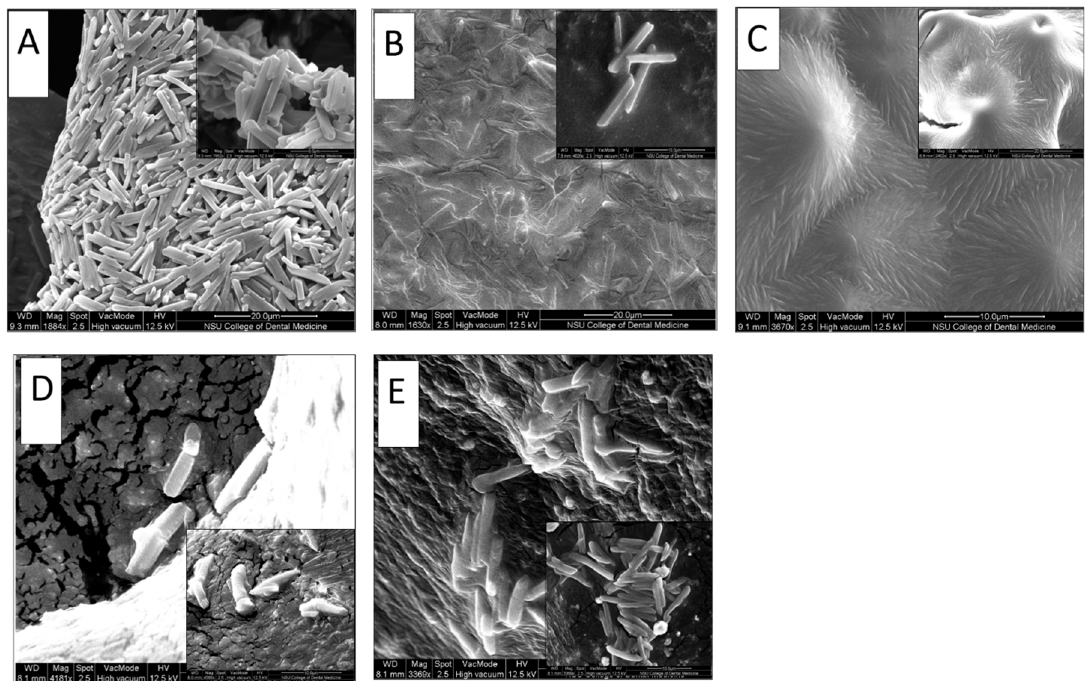
Figure 4. SEM images for ( A ) NPH only, ( B ): NPH-PF127 by direct dissolution in PF127, ( C ) NPH-PF127 by the centrifugation of NPH, ( D ) NPH in the presence of trypsin (1 U/mL), ( E ) NPH-PF127 in the presence of trypsin.